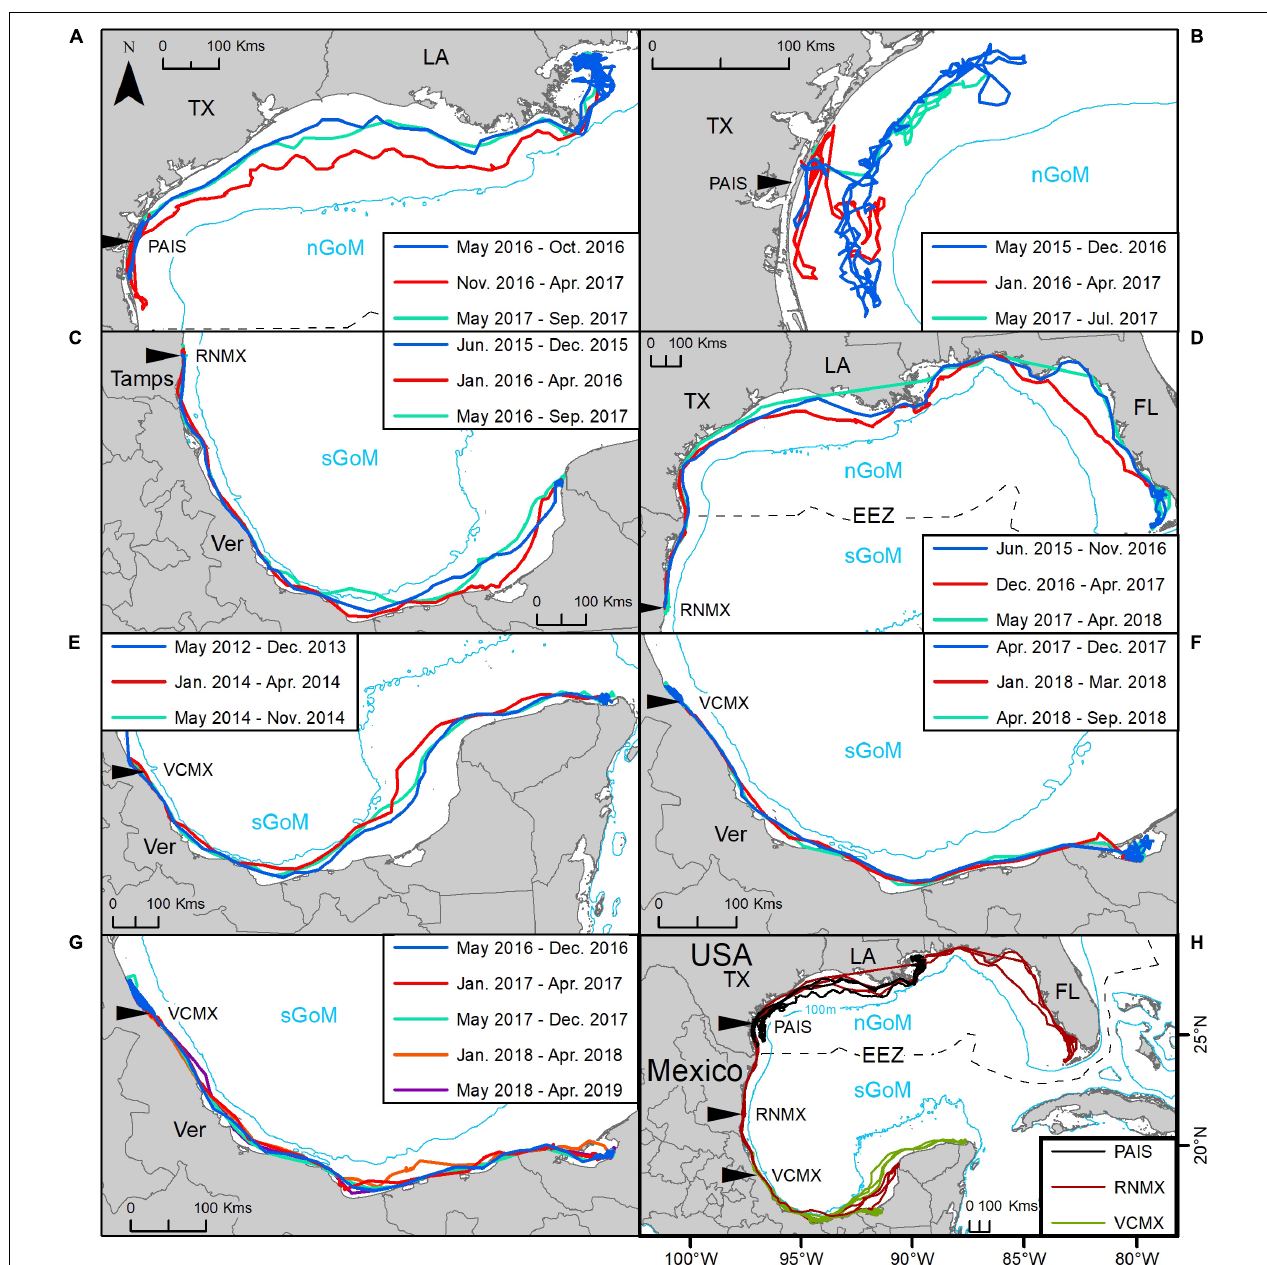
FIGURE 6 | Tracking of seven post-nesting female Kemp’s ridley sea turtles from the primary and major secondary nesting beaches that remigrated from foraging areas to their nesting beach: (A,B) Padre Island National Seashore, Texas, United States (PAIS); (C,D) Rancho Nuevo, Tamaulipas (Tamps), Mexico (RNMX); (E–G) Tecolutla, Veracruz (Ver), Mexico (VCMX). (H) Tracks of all individuals. The Exclusive Economic Zone (EEZ) demarcates the division between the northern Gulf of Mexico (nGoM) and southern Gulf of Mexico (sGoM). Tracks were reconstructed from mean daily locations of switching state-space model-derived location data. Transmitters were deployed between 2010 and 2017. Line colors correspond to each migration; blue: first migration from the nesting beach to foraging grounds; red: first return migration to the nesting beach; turquoise: second return migration from the nesting beach to foraging grounds; orange: second return migration to the nesting beach; purple: third migration from the nesting beach to foraging